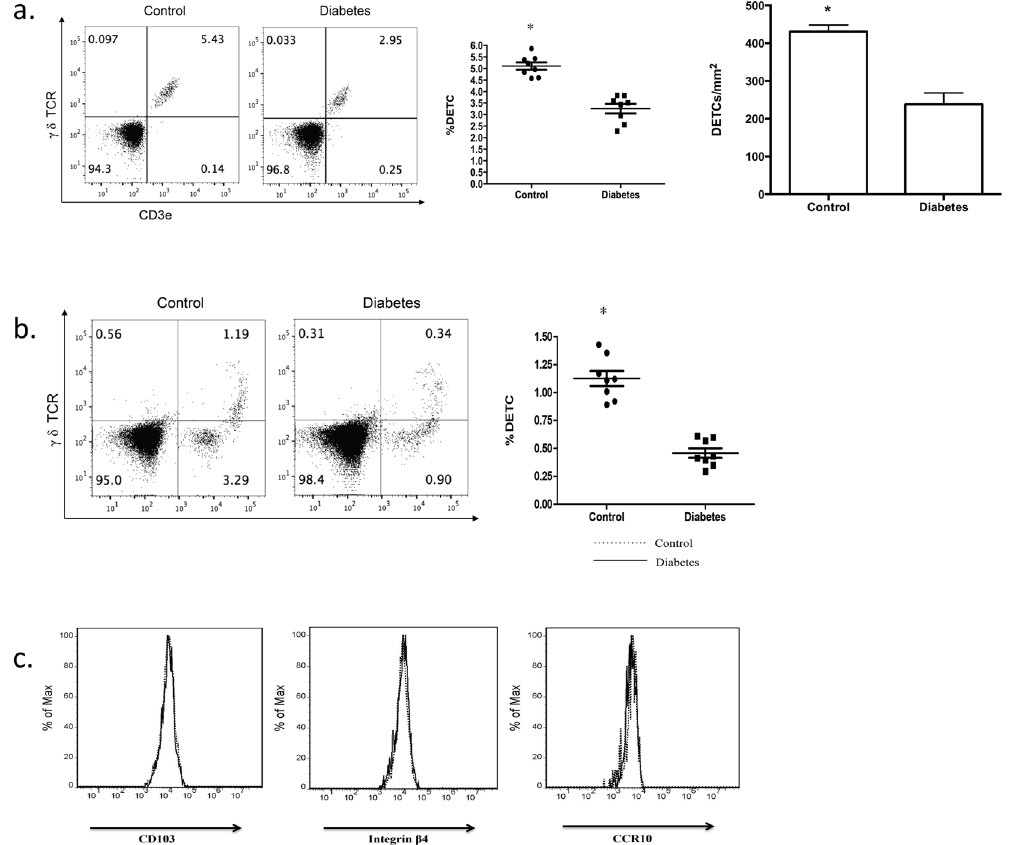
Figure 2. The reduction of DETCs in diabetic mice is likely to result from altered homeostasis without enhanced egression. 6–8 weeks wild-type male C57BL/6J mice were administered STZ to induce diabetes or vehicle control daily for 6 days. The mice were administered full-thickness wounds in their back skin 4 weeks later. At day 1 after wounding, epidermal sheets around wounds in STZ-induced diabetic or control mice were excised. ( a ) Single cell suspensions of epidermal sheets were stained with γ δ TCR and V γ 3 antibodies. ( b ) Single cell suspensions of dermal sheets from control and diabetic mice without wounds were stained with γ δ TCR and V γ 3 antibodies. ( c ) The expression levels of CD103, integrin β 4, and CCR10 on DETCs from STZ-induced diabetic or control mice were examined by means of FACS. All data represent at least three independent experiments and each experiment includes 2 animals (one control and one experimental mouse). All error bars represent mean ± SEM. * P <